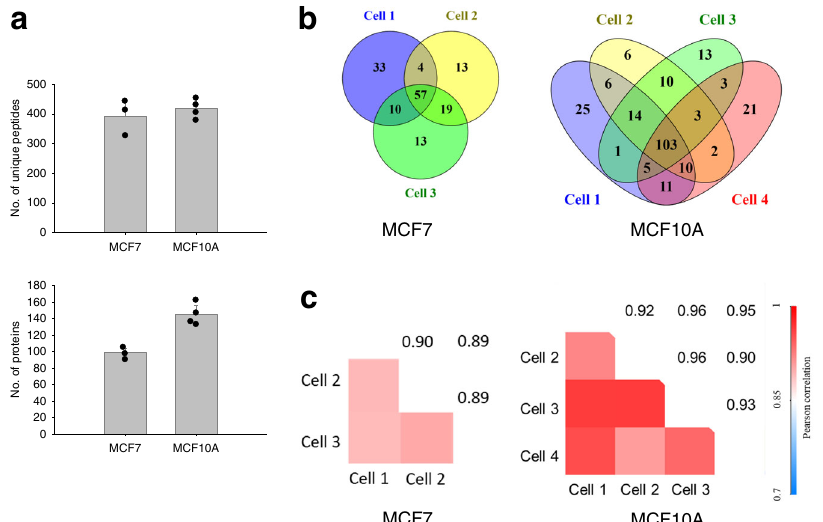
Fig. 4 Validation of SOP-MS for quantitative single-cell proteomics analysis. a Number of unique peptides and protein groups identi fi ed by the MS/MS spectra alone from three single MCF7 cells and four single MCF10A cells (from newly cultured MCF10A cells) sorted by FACS. b Venn diagram showing the number of protein groups identi fi ed from each of single MCF7 or MCF10A cells. c Pairwise correlation of log 10 -transformed protein LFQ intensities between any two replicates from the three single MCF7 cells and the 4 single MCF10A cells. Pearson correlation coef fi cients were color coded as shown on the scale at the bottom. Half of the sample injection was used for the analysis of single MCF7 cells (i.e., 0.5 single MCF7 cells for MS